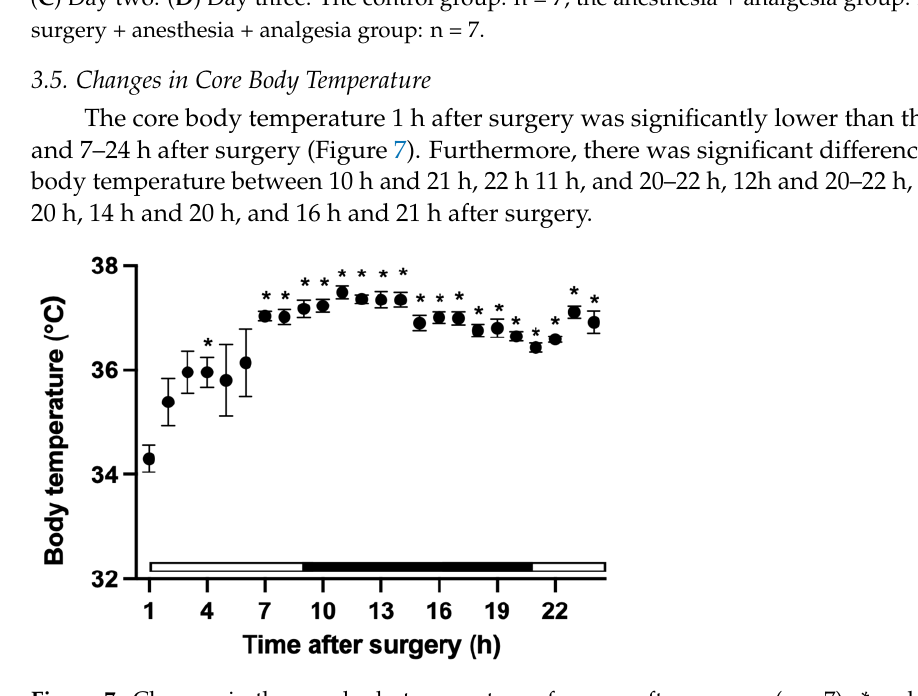
Figure 6. Kaplan–Meier analysis of the latency to burrow: ( A ) Day before treatment. ( B ) Day one. ( C ) Day two. ( D ) Day three. The control group: n = 7, the anesthesia + analgesia group: n = 7, the surgery + anesthesia + analgesia group: n = 7.